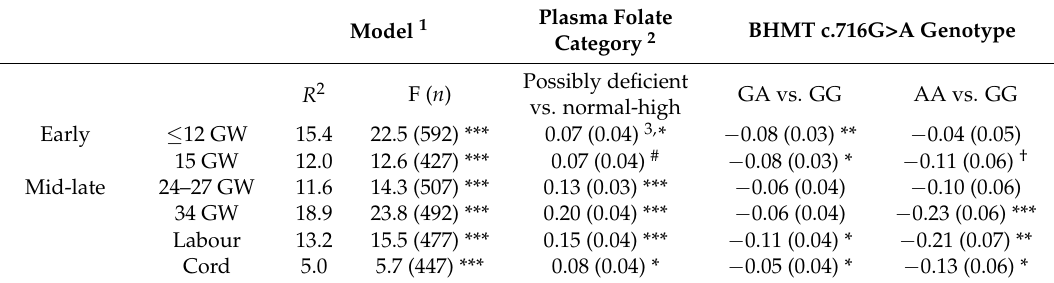
Table 3. Change in plasma dimethylglycine throughout pregnancy according to plasma folate category, and BHMT c.716G>A genotype.